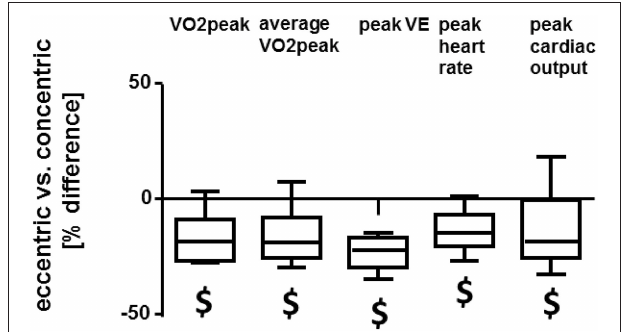
FIGURE 5 | Cardiovascular differences between interval-type concentric and eccentric exercise. Box Whisker plots of the percentage differences between the eccentric vs. the concentric protocol for cardiovascular parameters. $: p < 0.05 for eccentric vs. concentric exercise. Repeated ANOVA for the repeated factor of the exercise protocol performed (i.e., concentric, eccentric) with post-hoc test for least significant difference.